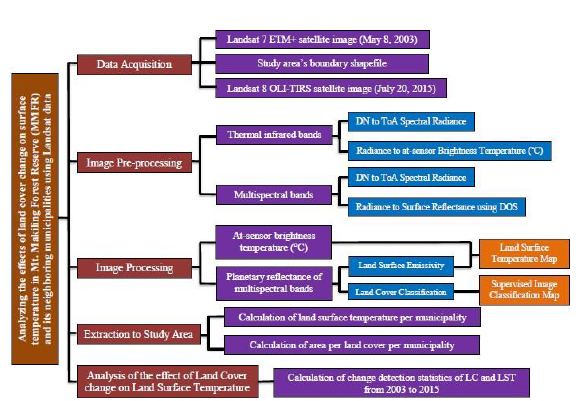
Figure 2. Methodological